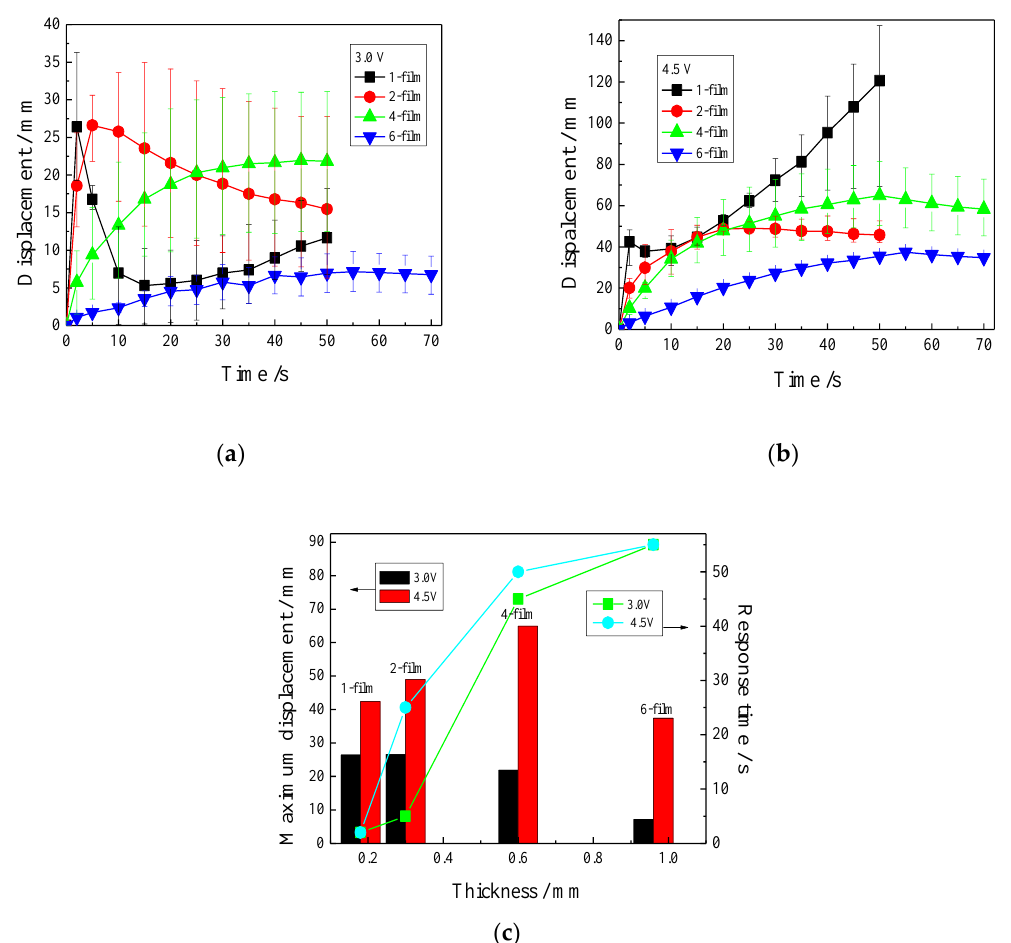
Figure 6. Displacements of the IPMCs with various thicknesses under different voltages. ( a ) 3.0 V; ( b ) 4.5 V; ( c ) relationships between the maximum displacements or the response time and the thicknesses.